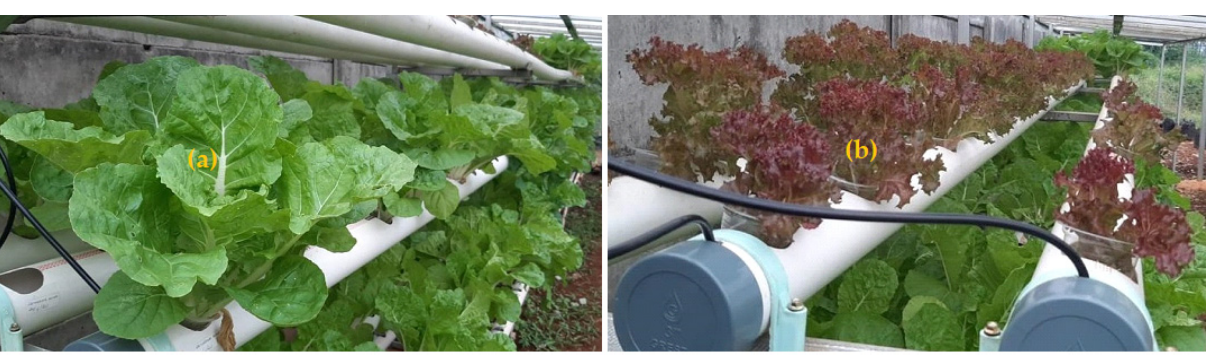
Figure 1. Cultivation of vegetables: ( a ) mustard greens and ( b ) watercress.